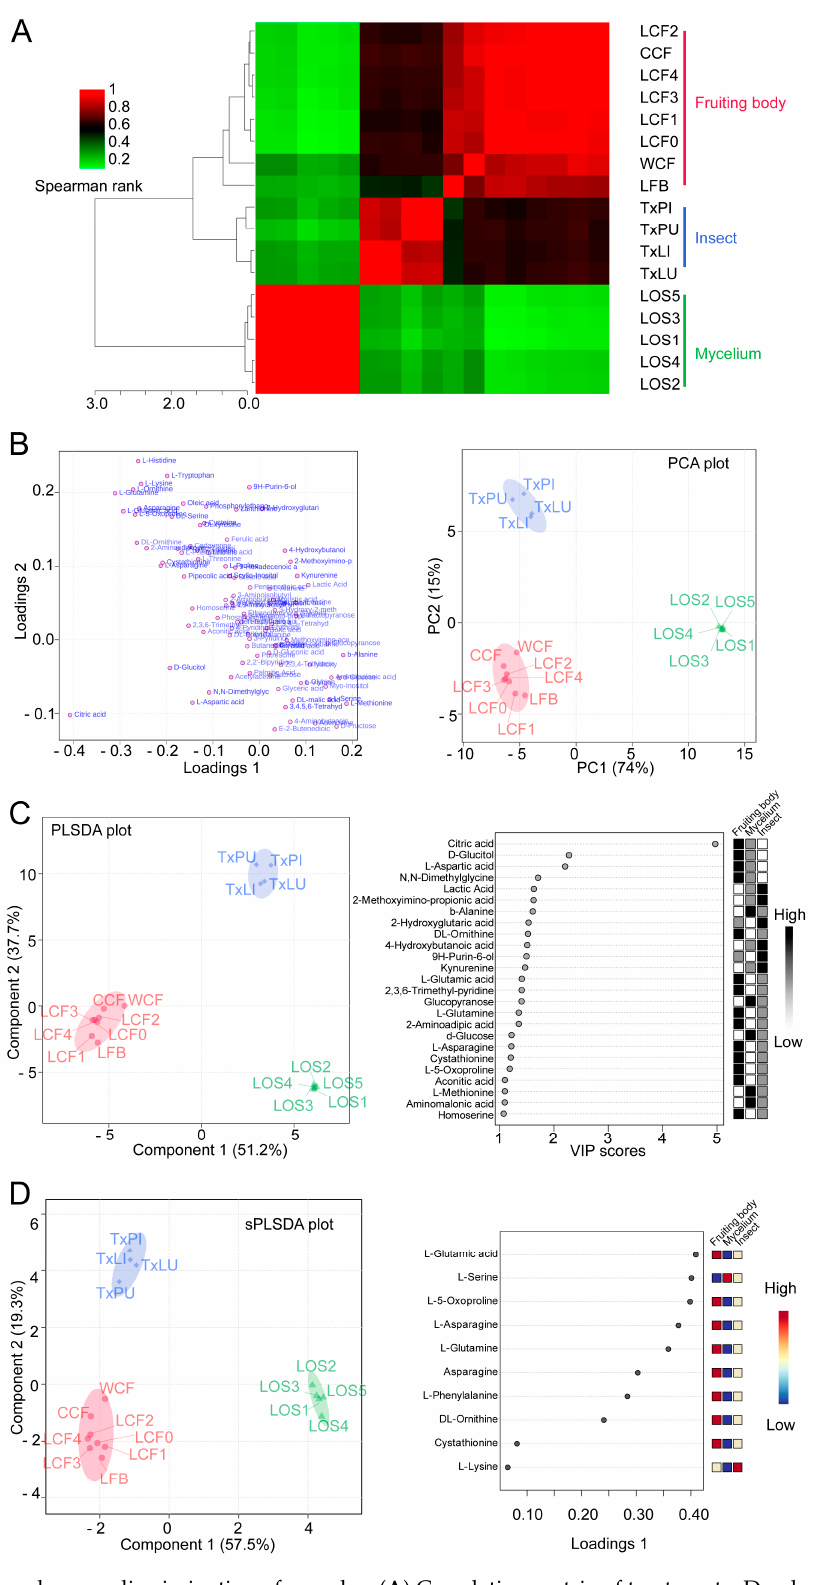
Figure 4. Clustering and group discrimination of samples. ( A ) Correlation matrix of treatments. Dendrogram was obtained using hierarchical clustering from the metabolic profiling in the fruiting body (red), insect (blue) and mycelium (green). ( B ) Loading plot (left) and scores plot (right) from principal component analysis (PCA) between the selected PCs. Circle indicates 95% C.I. ( C ) Partial least squares—discriminant analysis plot (PLSDA, left) and top 25 featured metabolites